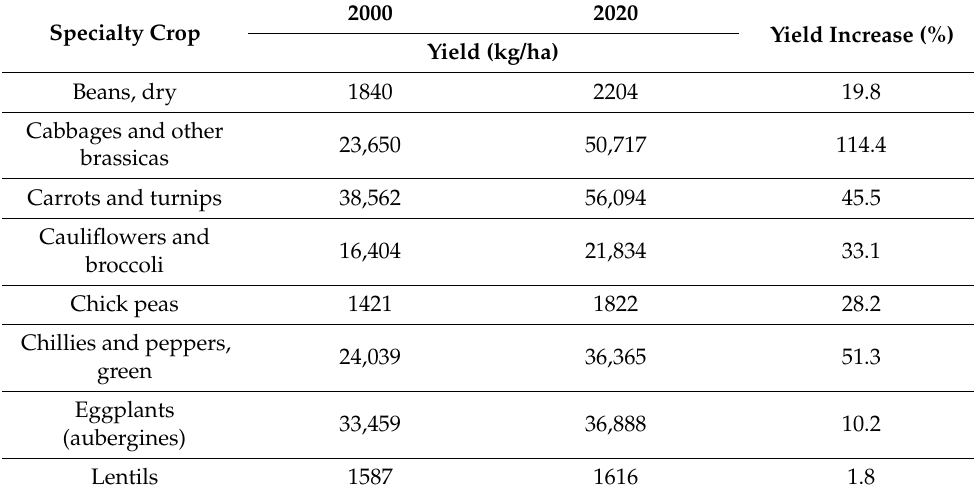
Table 1. Yield increases of selected specialty crops in the United States between 2000 and 2020. (Data extracted from FAOSTAT https://www.fao.org/faostat/en/#data/QCL) (accessed on 3 December 2021) 50% of total yield increase may be attributed to crop breeding